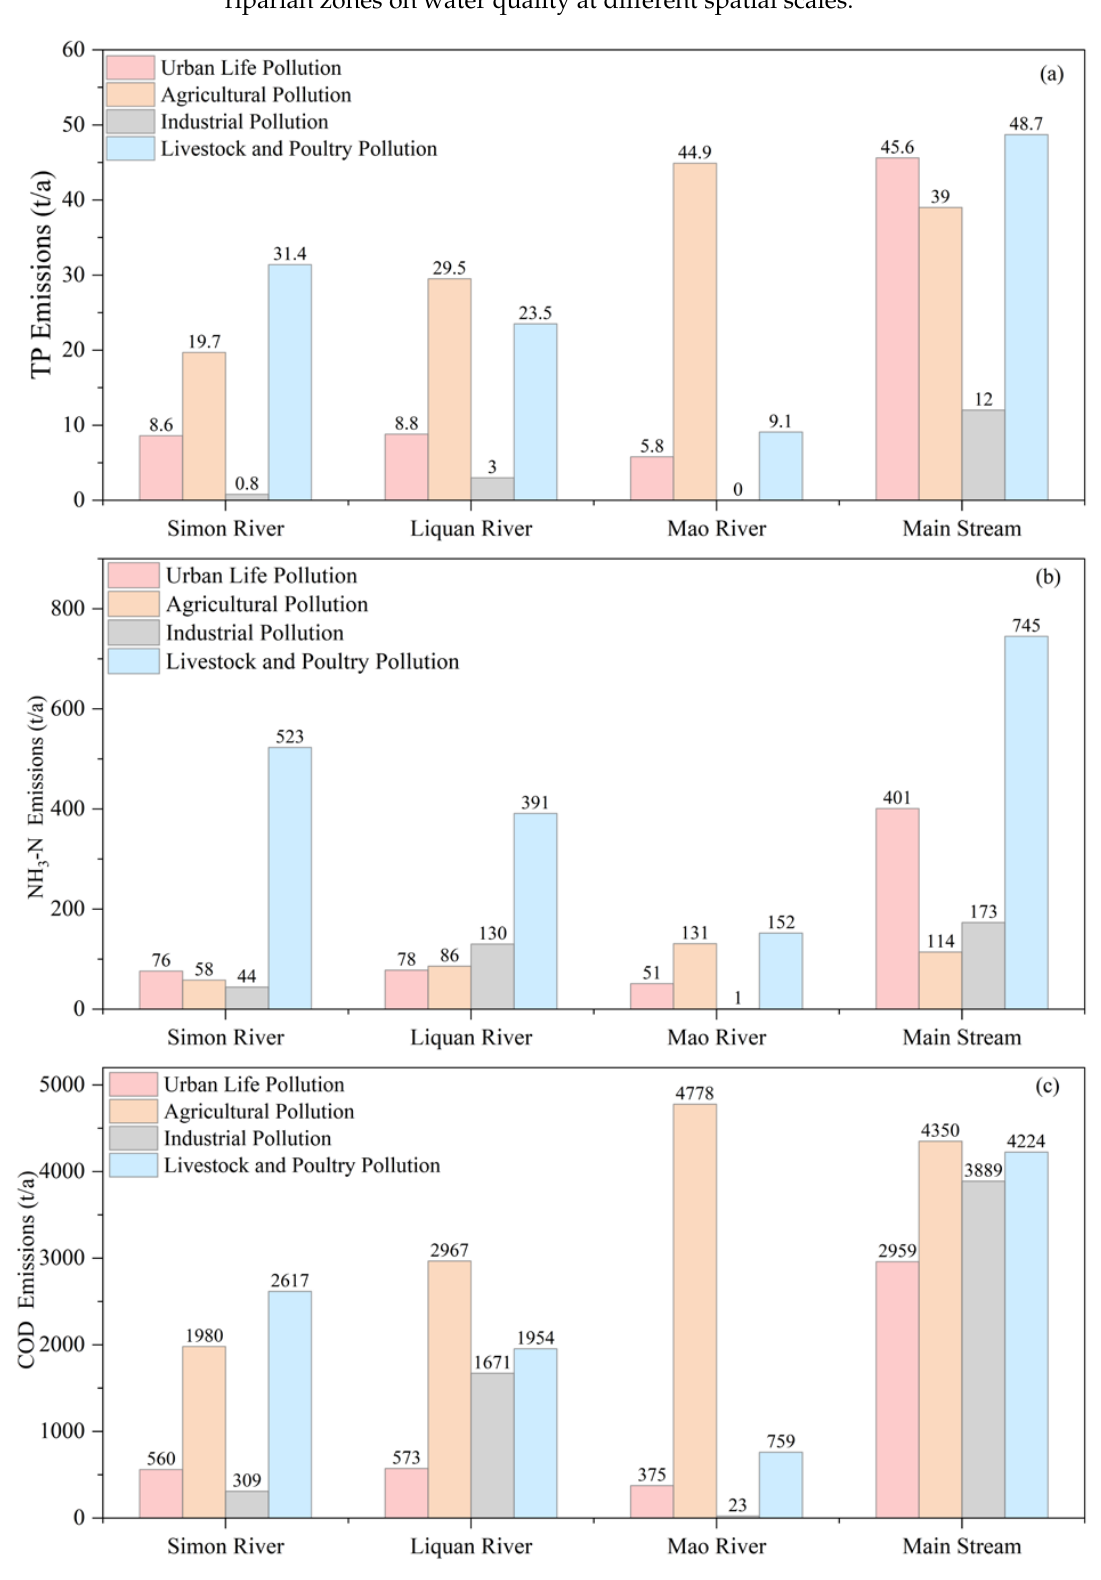
Figure 8. Discharge of pollutants into the main streams and important tributaries in the study area. TP emissions ( a ), NH 3 -N emissions ( b ), COD emissions ( c ).